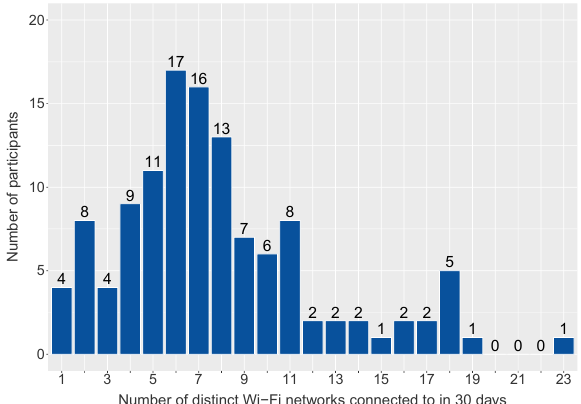
Figure 1. Number of Wi-Fi networks connected to by participants during the 30-day study. On average, participants connected to eight networks, with the vast majority of them (61%) connecting to anywhere between 4–8